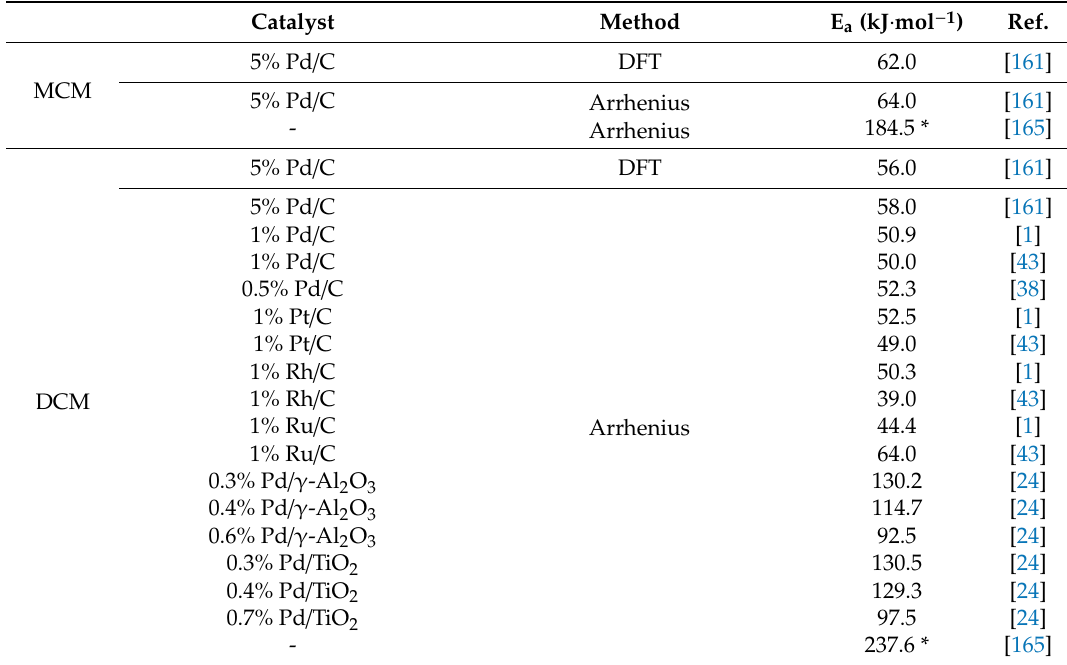
Table 2. Activation energies for the HDC of